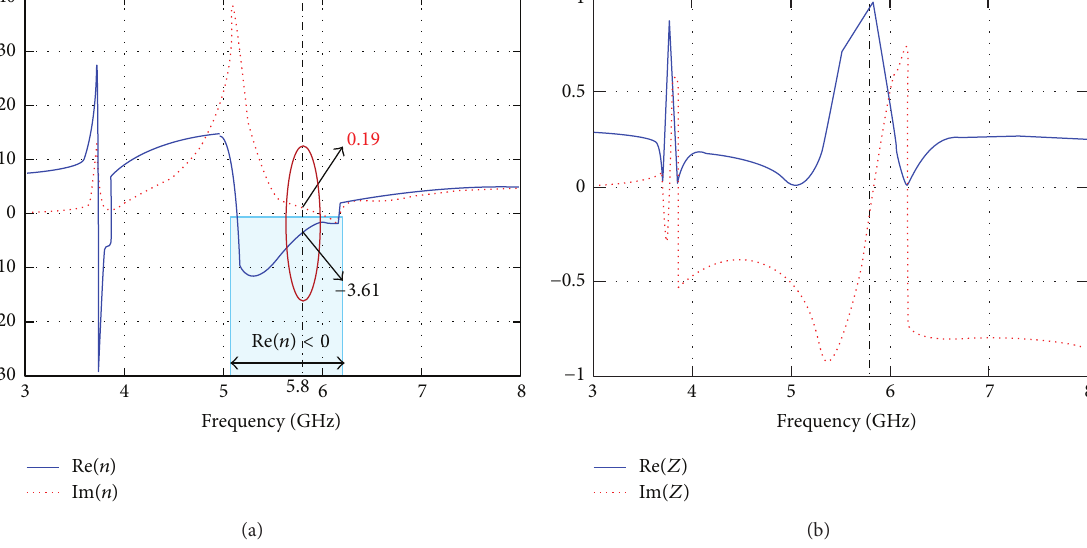
Figure 10: Effective refraction index (a) and normalized impedance (b) of FL-LHM unit-cell under an incident wave of 45 ∘ extracted